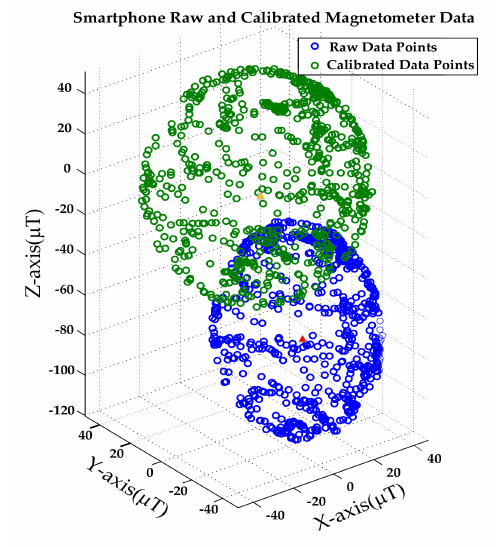
Figure 4. Blue dots are un-calibrated raw data and green dots are calibrated